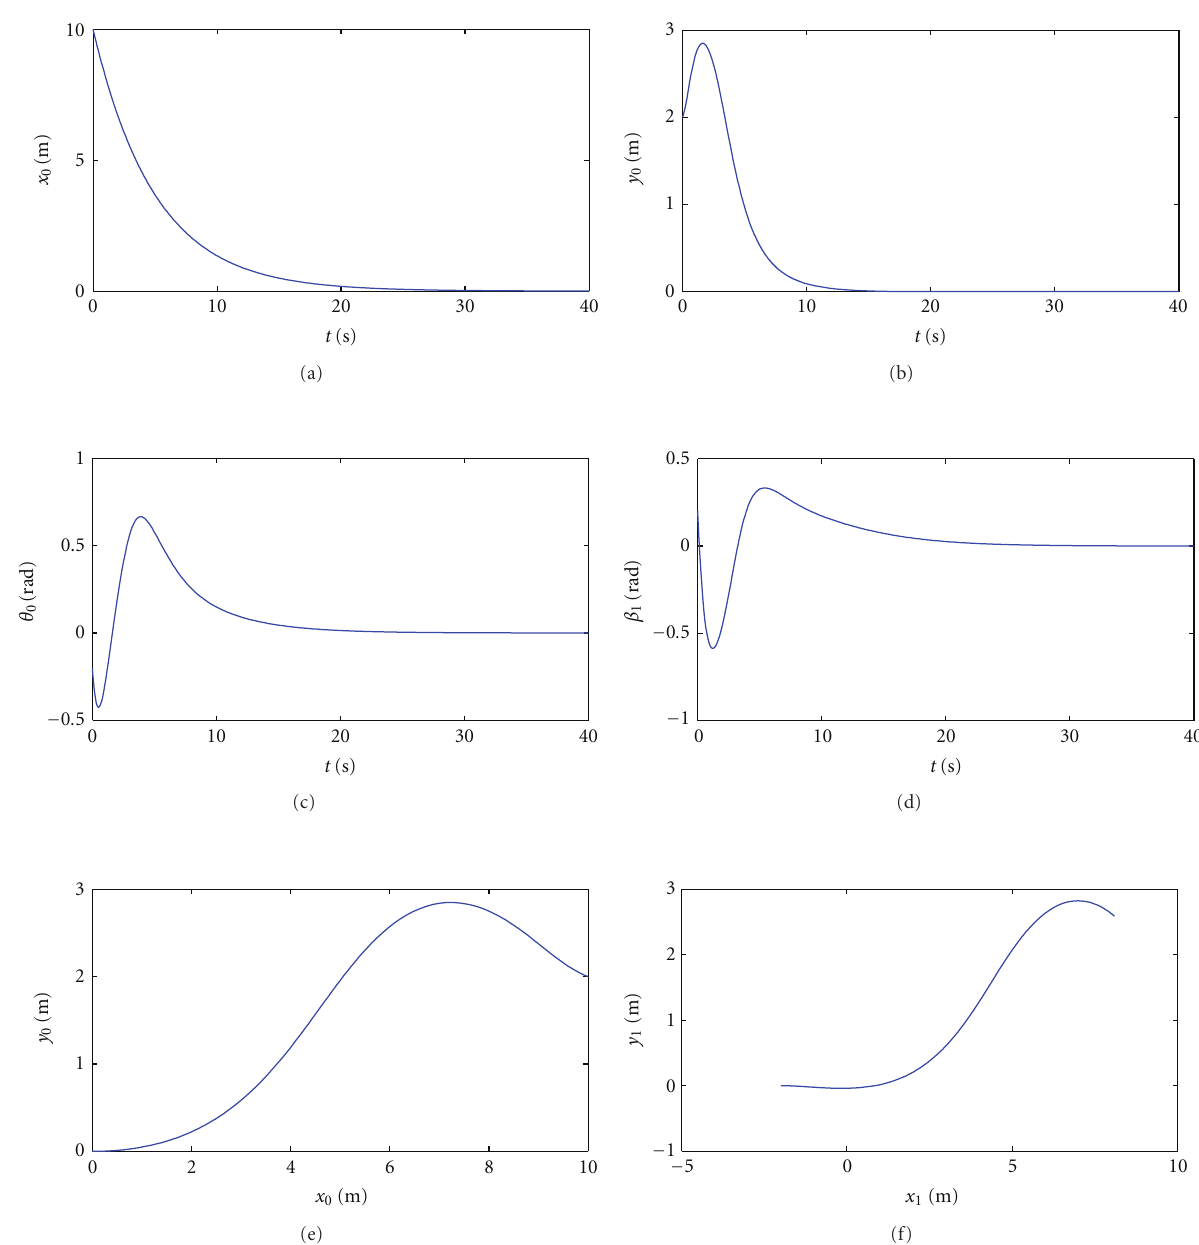
Figure 2: Time trajectories of states and geometric paths of the tractor and the trailer starting from the first initial state.